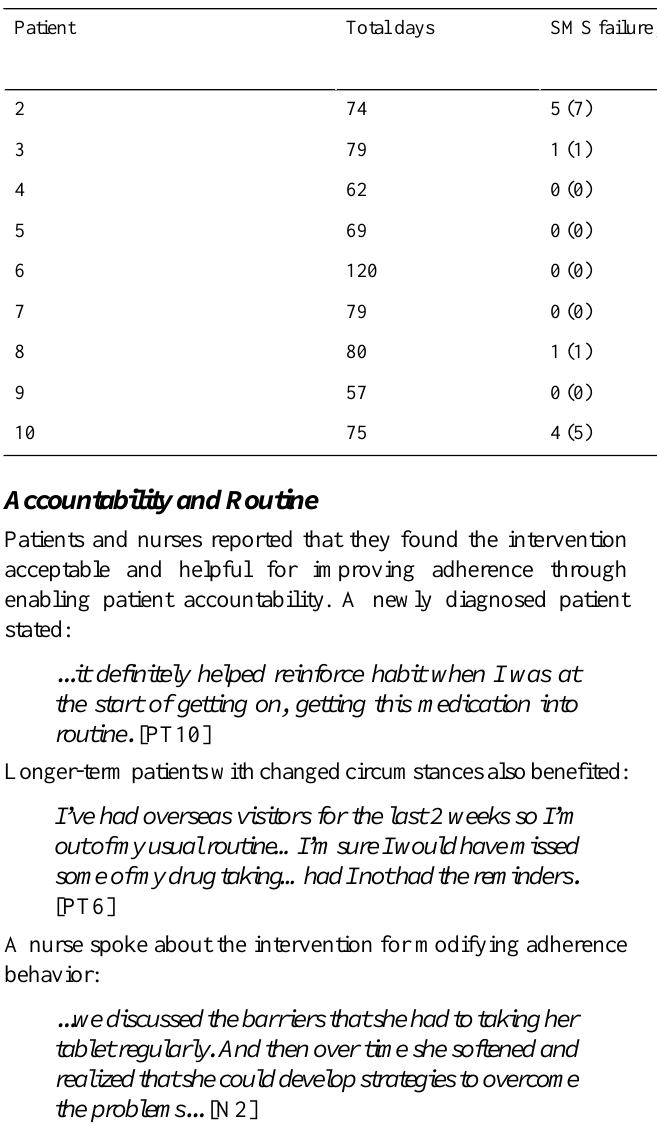
Table 2. System administrator details of SMS (short message service) texts sent and answered by